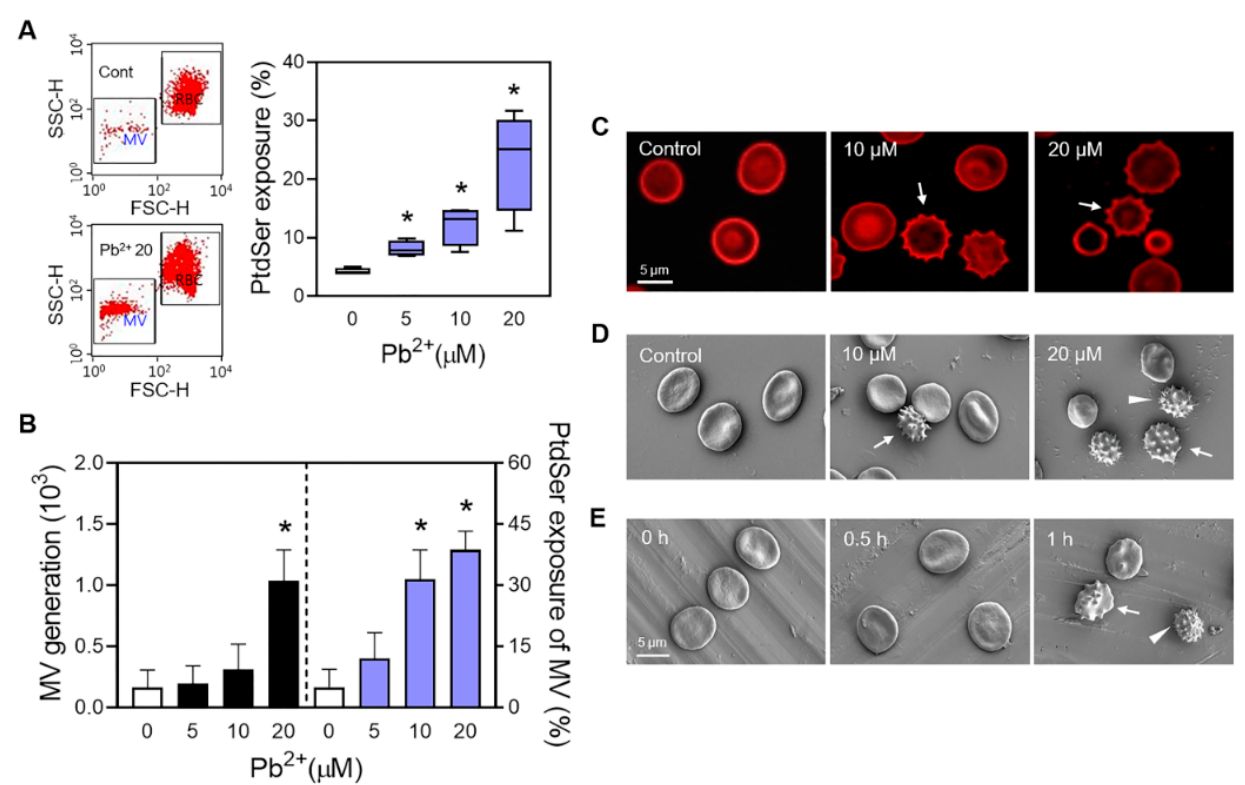
Figure 2. Pb treatment augments eryptosis and shape changes of human erythroid cells. After isolated human erythroid cells were treated with various concentrations (0, 5, 10, and 20 μ M) of Pb. ( A ) PtdSer exposure ( n = 4). ( B ) MV generation and PtdSer exposure of MV were concentration-dependent promoted, which was determined by using flow cytometry. ( C – E ) Erythroid cells shape changes were examined by using a confocal microscope ( n = 4) and a scanning electron microscope ( n = 3), respectively. Values are the mean ± SD of 3–4 experiments. Scale bars ( C – E ): 5 μ m. * Statistical difference compared with control ( p < 0.05).